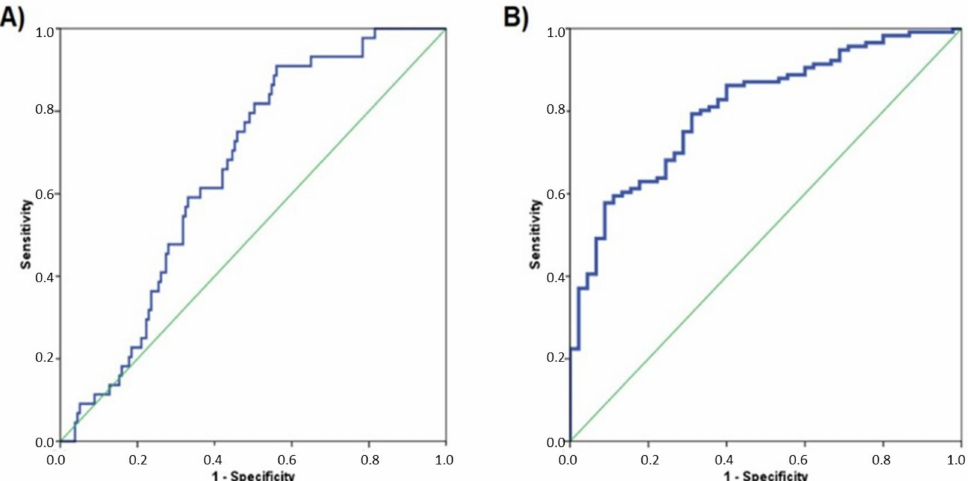
Figure 3. Receiver operating characteristic (ROC) curves for miR-21. ( A ) ROC curve including the patients for the four cancer groups: Area Under the Curve (AUC) = 0.675 (95% CI: 0.578–0.736; p = 0.001). ( B ) ROC curve excluding the cohort of PCa patients: AUC = 0.808 (95% CI: 0.738–0.878; p < 0.0001). ROC curve calculated is represented with blue line and green line is used as a reference.